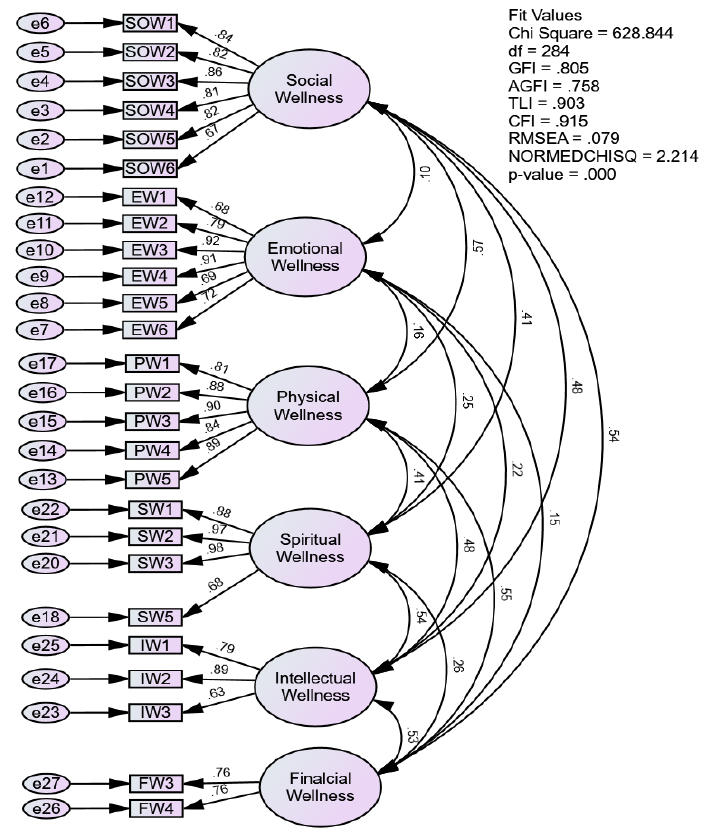
Figure 2. First-order model of wellness dimensions.